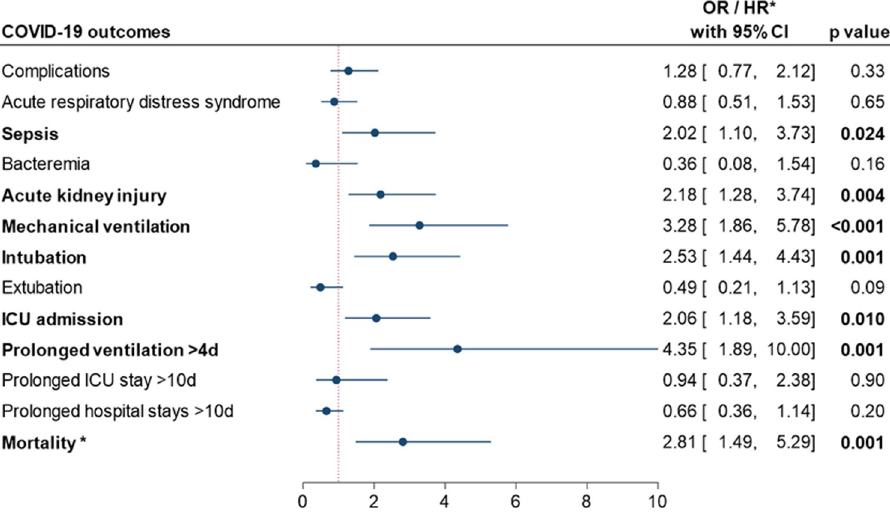
Fig 2. Impact of altered mental status as a predictor risk factor for poor outcomes. Multiple regression analysis was iterated using binary logistic regression models for all outcomes and cox hazard proportionate regression model for survival, adjusted by age, sex, obesity, and neuropsychiatric comorbidity. Results are reported as odds ratio (OR) for all outcomes or hazard ratio (HR � ) for